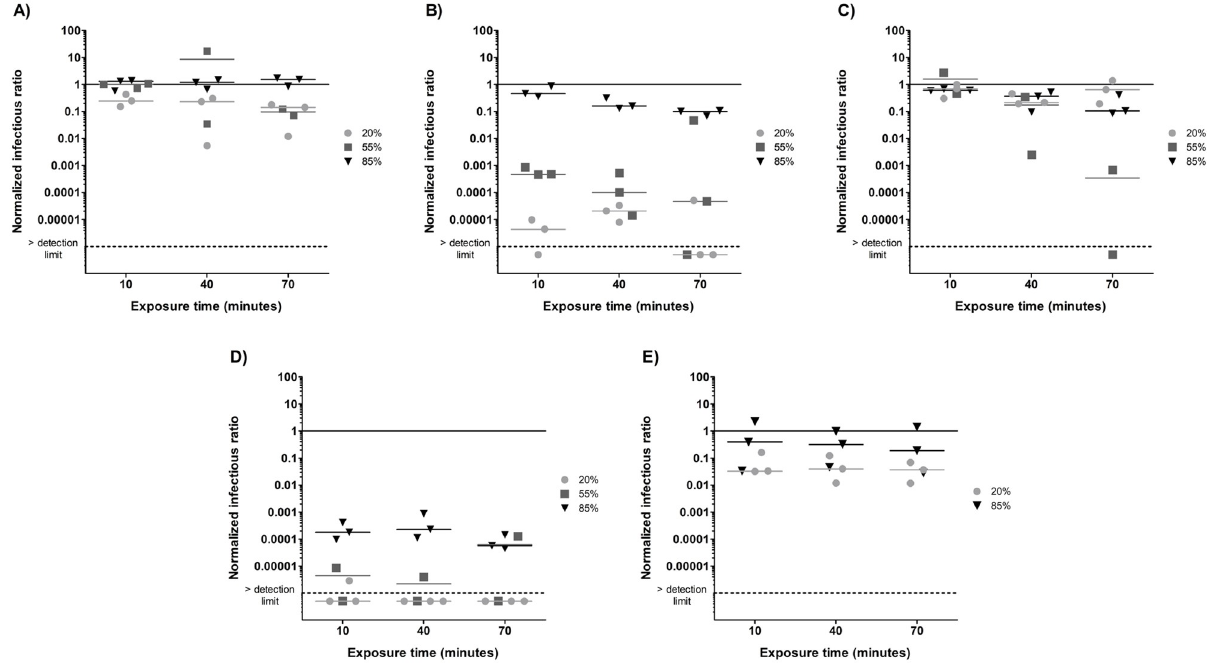
Fig 2. Normalized infectious ratios at three levels of relative humidity and three exposure times for A) φ X174, B) PR772, C) MS2 and D) φ 6 and two levels of relative humidity and three exposure times for E) MNV-1. The solid line represents the nebulizer content. The dotted line represents the detection limit.